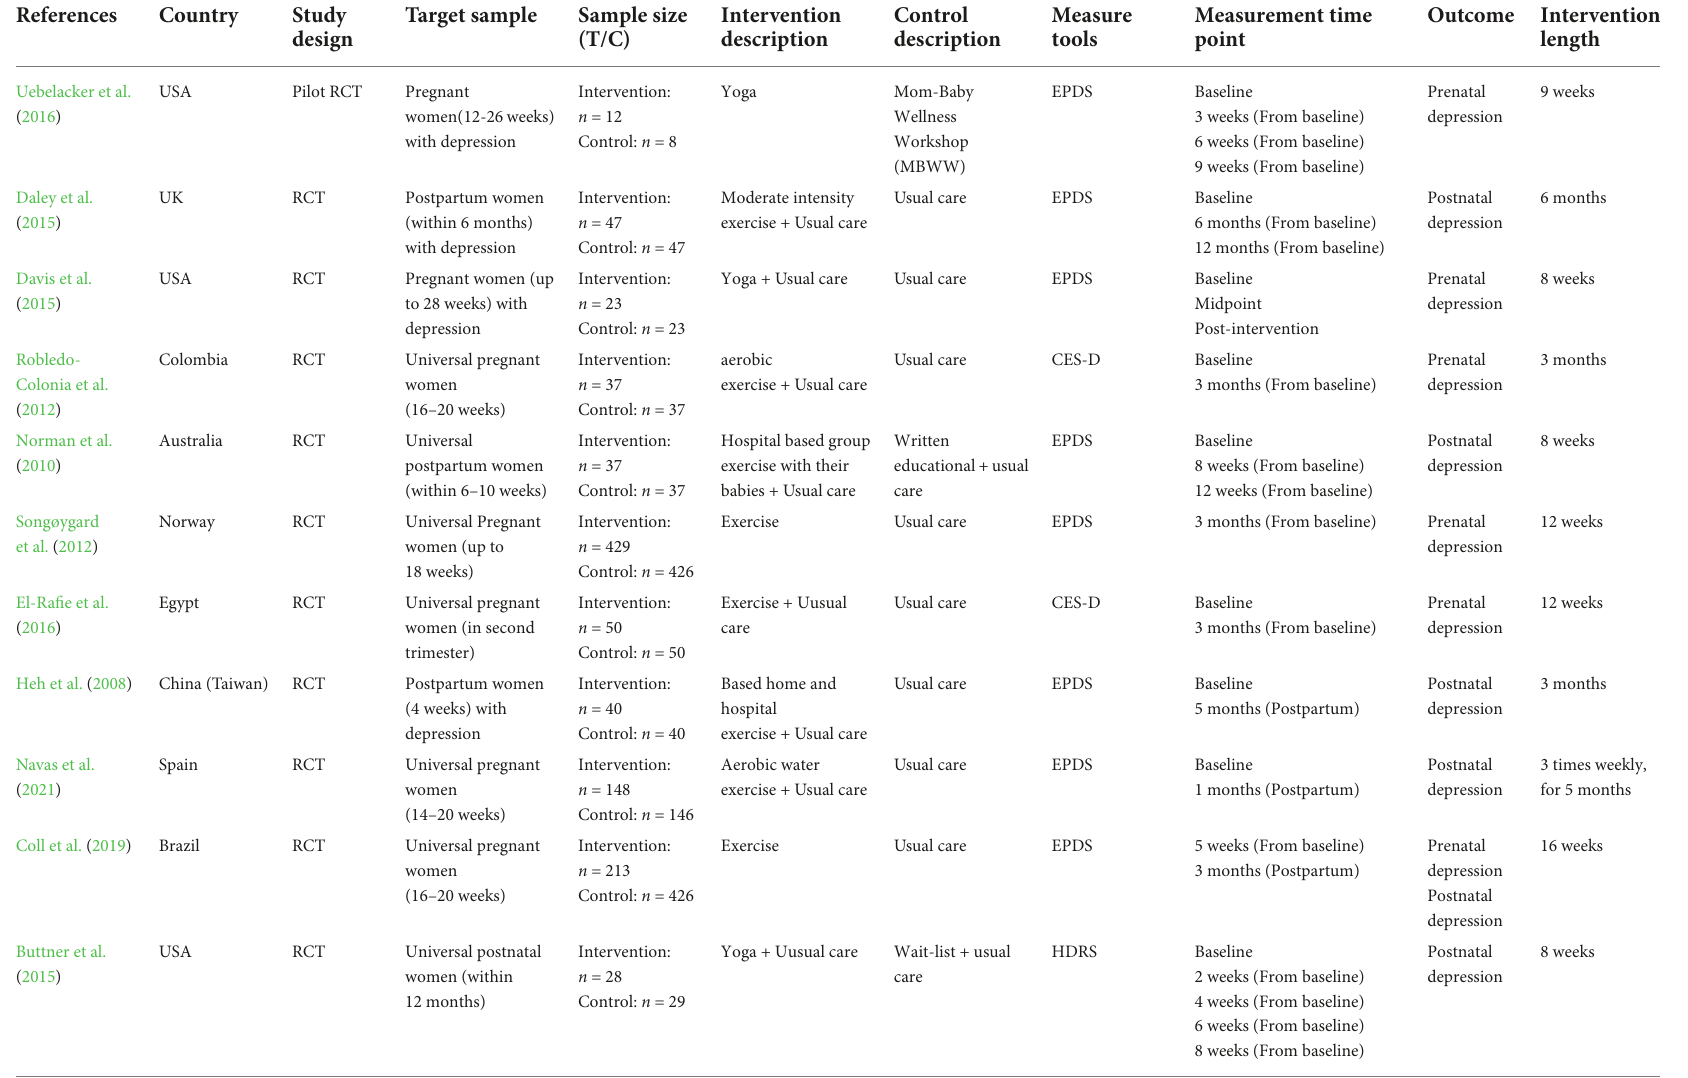
TABLE 1 Characteristics of randomized control trials included in the current